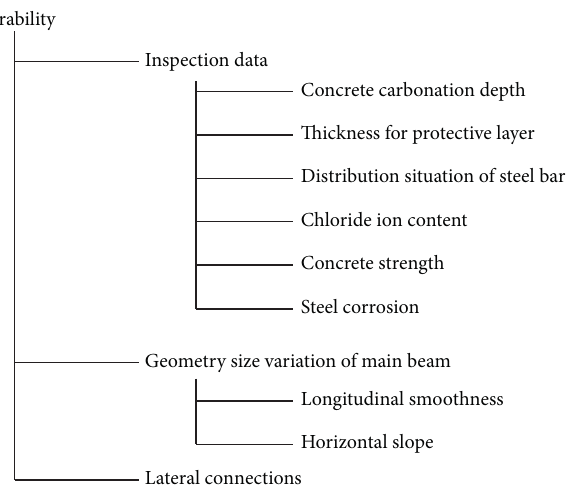
Figure 2: Index system for condition evaluation of bridge super-